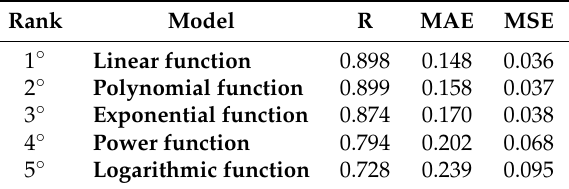
Table 6. Effective functions for forecasting yield.